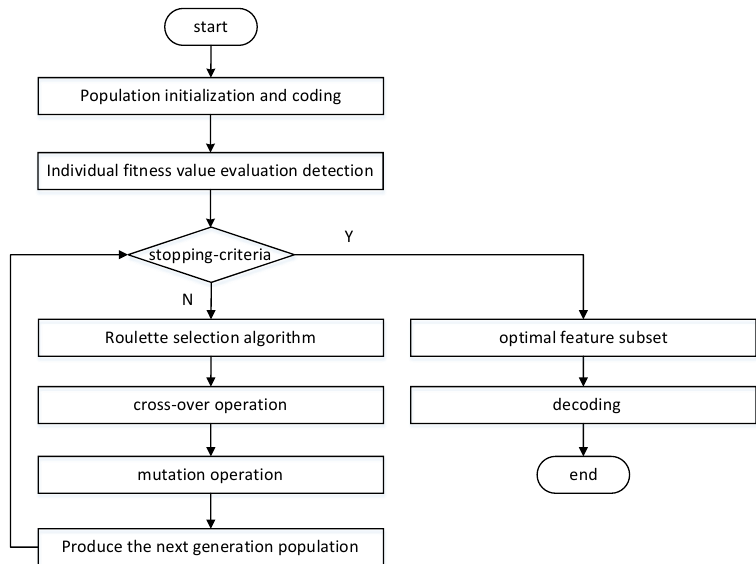
Figure 1. Genetic algorithm feature extraction flow chart.